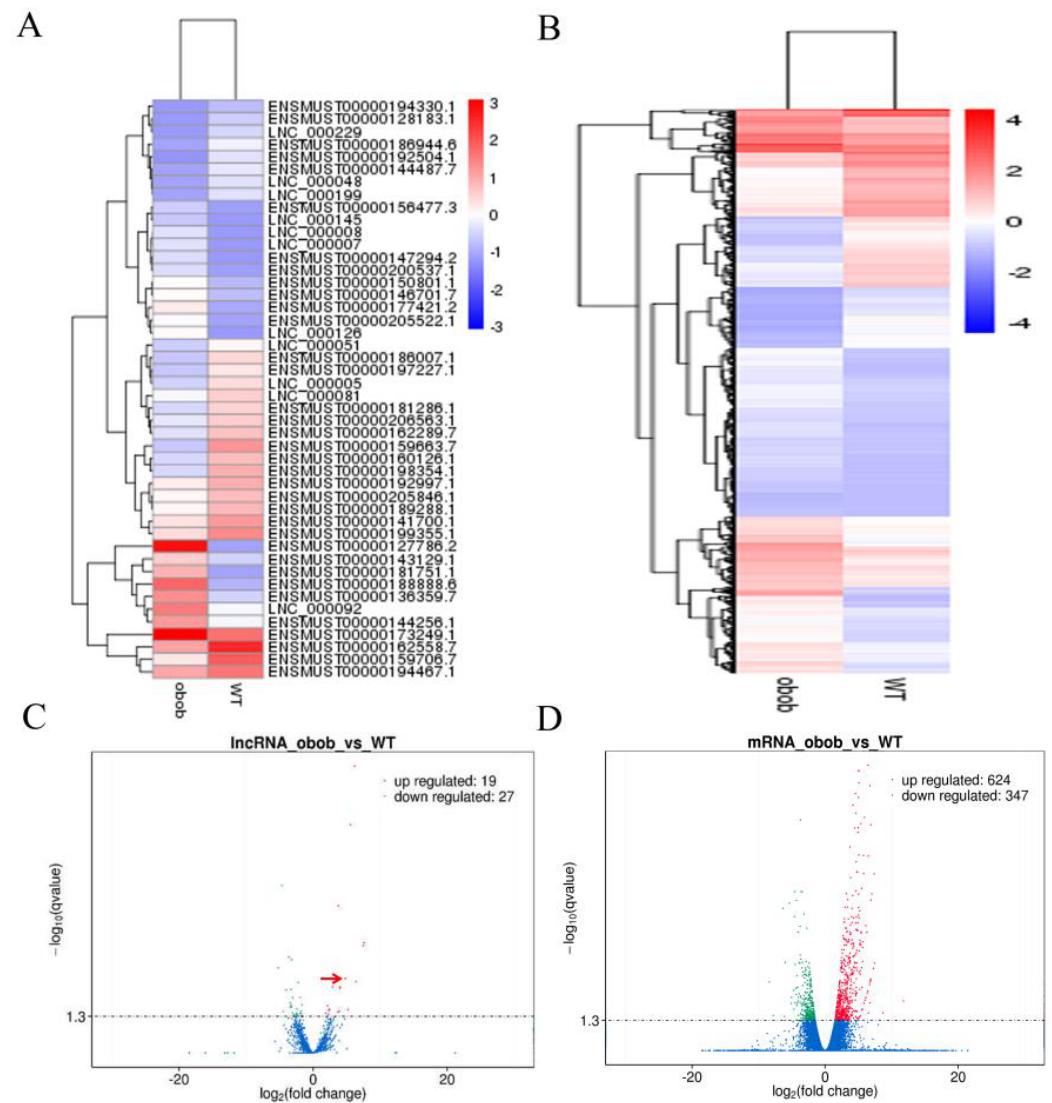
Figure 2. Di ff erentially expressed lncRNAs and di ff erentially expressed genes (DEGs) in WT and ob / ob Figure 2. Differentially expressed lncRNAs and differentially expressed genes (DEGs) in WT and ob/ob mice. ( A ) Heat map of the di ff erentially expressed lncRNAs in WT and ob / ob mice (fold change ≥ 2 mice. ( A ) Heat map of the differentially expressed lncRNAs in WT and ob/ob mice (fold c hange ≥2 and and q value ≤ 0.05). ( B ) The heat-map of the di ff erentially expressed mRNAs in WT and ob / ob mice q value ≤0.05). ( B ) The heat-map of the differentially expressed mRNAs in WT and ob/ob mice (fold (fold change ≥ 2; q -value ≤ 0.05). ( C ) Volcano plot of di ff erentially expressed lncRNAs. Among these change ≥ 2; q - value ≤ 0.05). ( C ) Volcano plot of differentially expressed lncRNAs. Among these lncRNAs, 19 lncRNAs were upregulated and 27 lncRNAs were downregulated in ob / ob mice. lnc-ORA lncRNAs, 19 lncRNAs were upregulated and 27 lncRNAs were downregulated in ob/ob mice. lnc-ORA was denoted by red arrow. ( D ) Volcano Plot of di ff erentially expressed mRNAs. Among these mRNAs, was denoted by red arrow. ( D ) Volcano Plot of differentially expressed mRNAs. Among these 624 mRNAs were upregulated and 347 mRNAs were downregulated in ob / ob mRNAs, 624 mRNAs were upregulated and 347 mRNAs were downregulated in ob/ob mice.